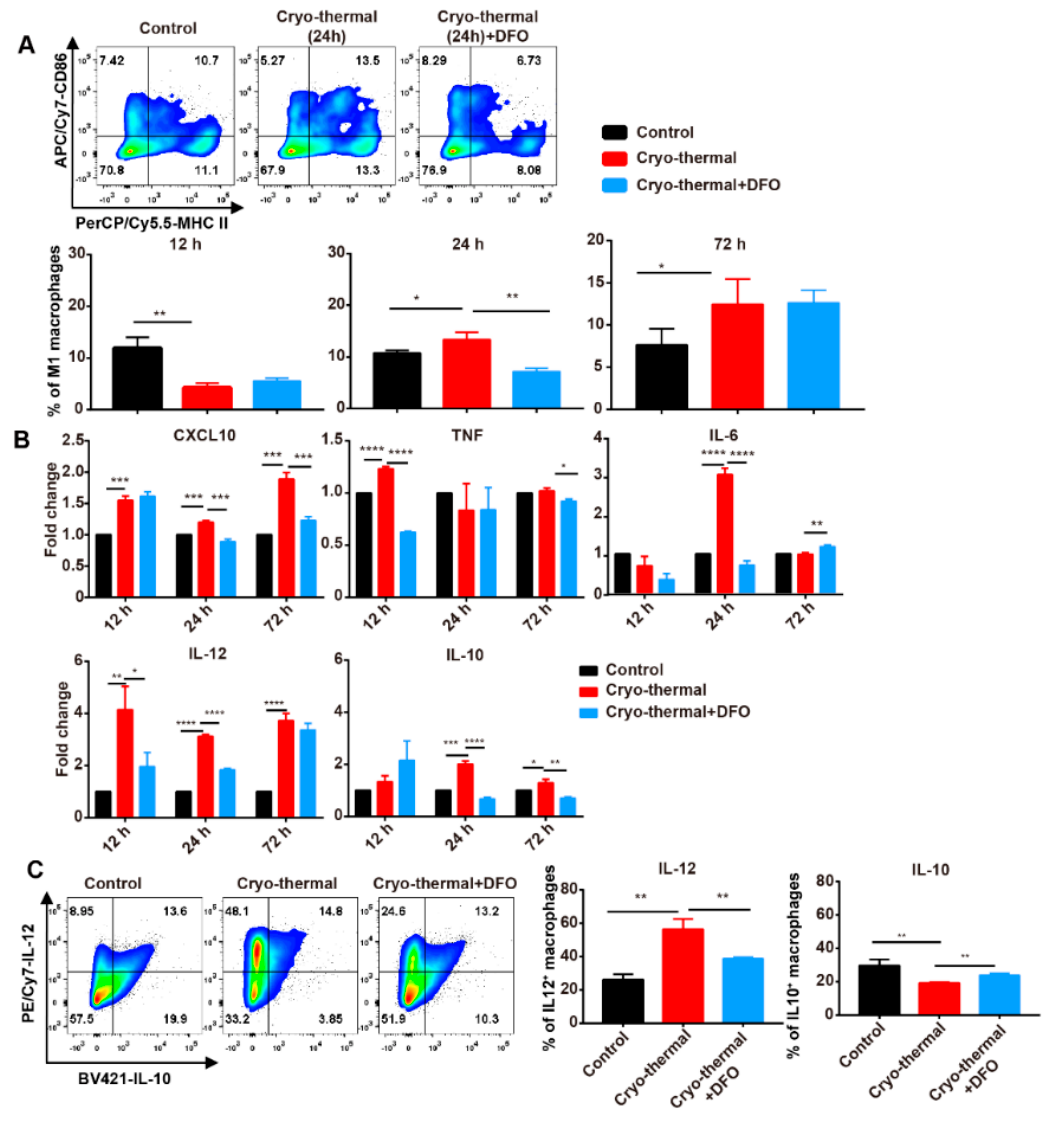
Figure 3. DFO treatment inhibited the M1 polarization of macrophages. Mice were sacrificed and spleen were harvested 12 h, 24 h and 72 h after cryo-thermal therapy. ( A ) The percentages of M1 macrophages (CD86 + MHC II + ) were measured by using flow cytometry. ( B ) Macrophages were sorted and the expression levels of CXCL10 , TNF , IL-6 , IL-12 and IL-10 were determined by using RT-qPCR. ( C ) Intracellular IL-12 and IL-10 in macrophages were determined by using flow cytometry. * p < 0.05, ** p < 0.01, *** p < 0.001, **** p < 0.0001, n = 3 for each group.